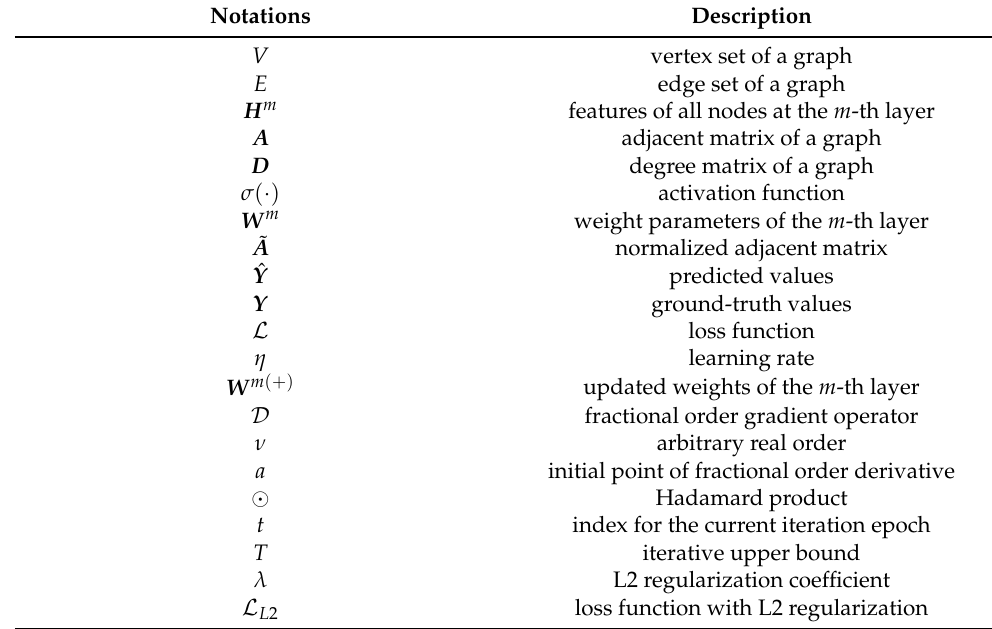
Table 1. Summary of the key